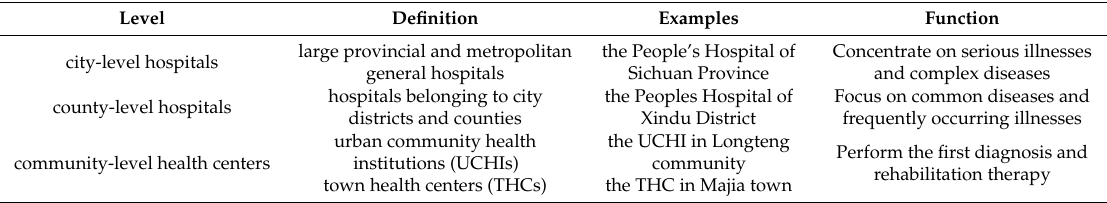
Table 1. Multilevel healthcare system and function of each level.